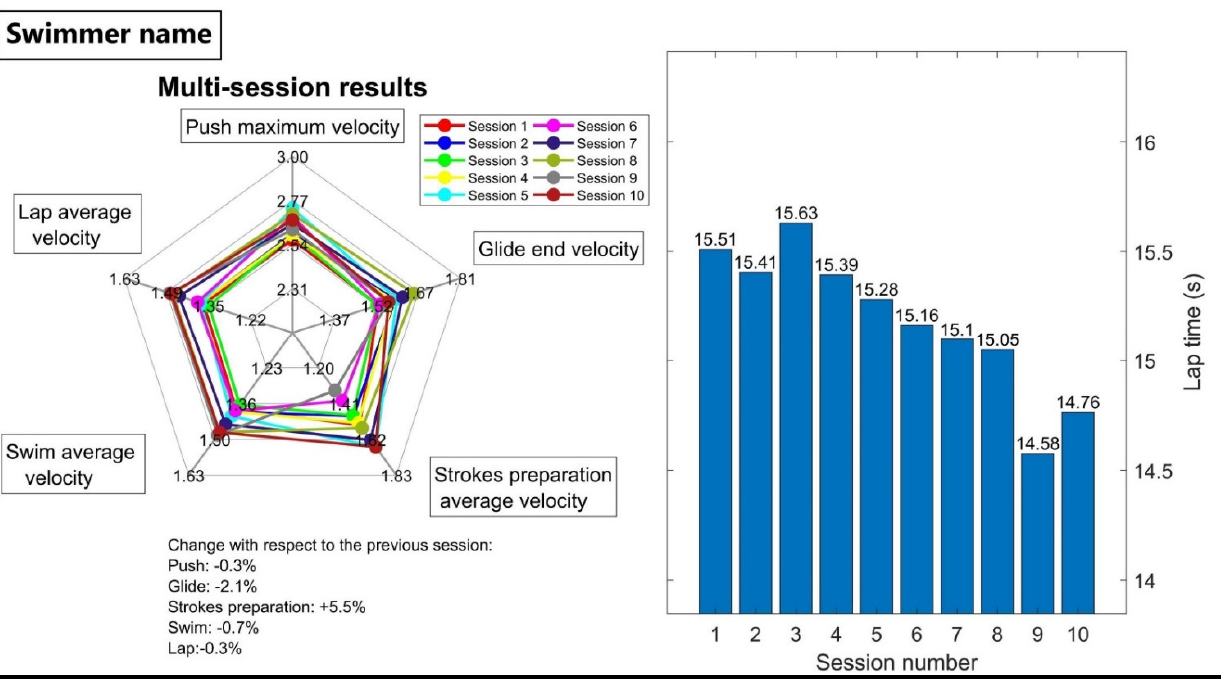
Figure 3. Feedback on multi-session performance evaluation feedback. The radar chart shows with a different color the average performance of all sessions ( left ) with changes compared to the previous session. The bar graph shows the average lap time of all sessions recorded by the coach ( right ).